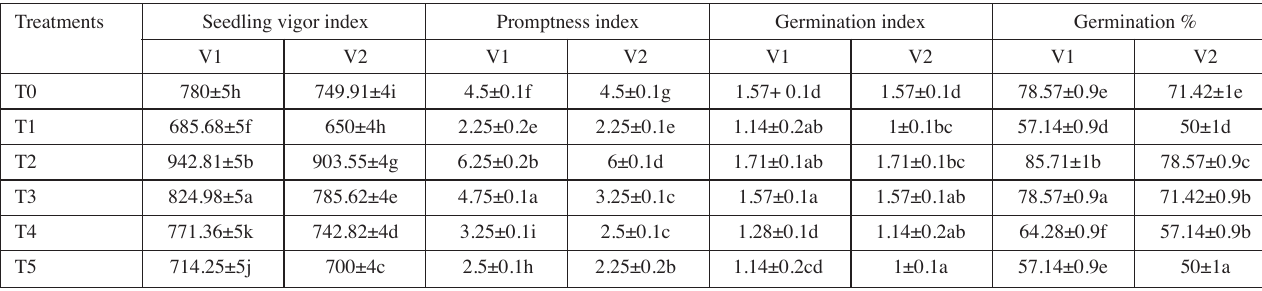
Tab. 1: Effect of Azospirillum inoculation on germination parameters of two canola varieties under drought stress. Treatments